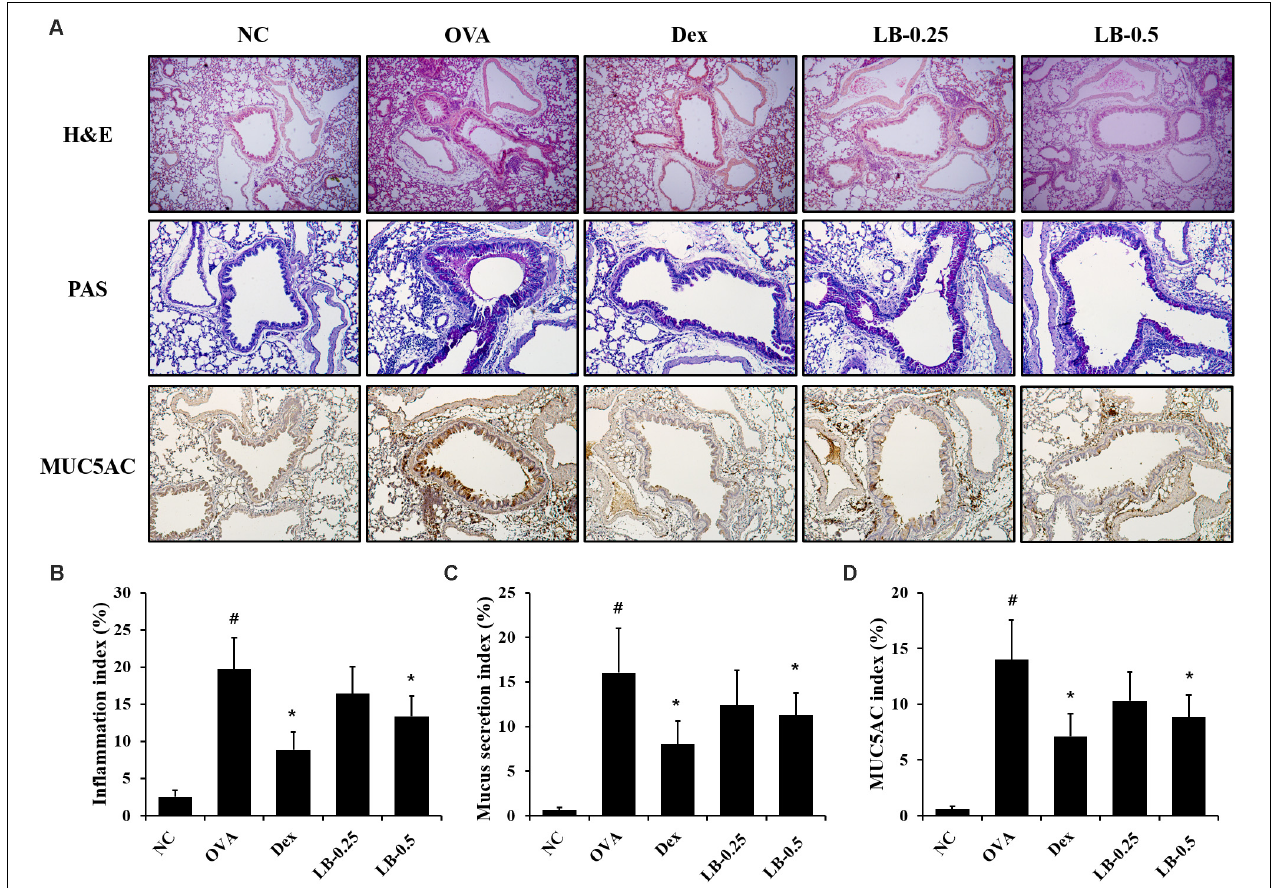
FIGURE 4 | Effects of lobeglitazone (LB) on airway inflammation, mucus production, and MUC5AC expression in lung tissue from OVA-challenged animals. (A) Representative figure of airway inflammation, mucus production, and MUC5AC expression in lung tissue. Quantitative analysis of airway inflammation (B) , mucus production (C) , and MUC5AC expression (D) in lung tissue, respectively. NC, normal control mice; OVA, OVA-sensitized/challenged mice; Dex, dexamethasone (3 mg/kg) + OVA-sensitized/challenged mice; LB-0.25 and –0.5, LB (250 µ g/kg or 500 µ g/kg, respectively) + OVA-sensitized/challenged mice. Values are expressed as mean ± SD ( n = 6/group). # Significantly different from NC, P < 0.05. ∗ Significantly different from OVA, P <